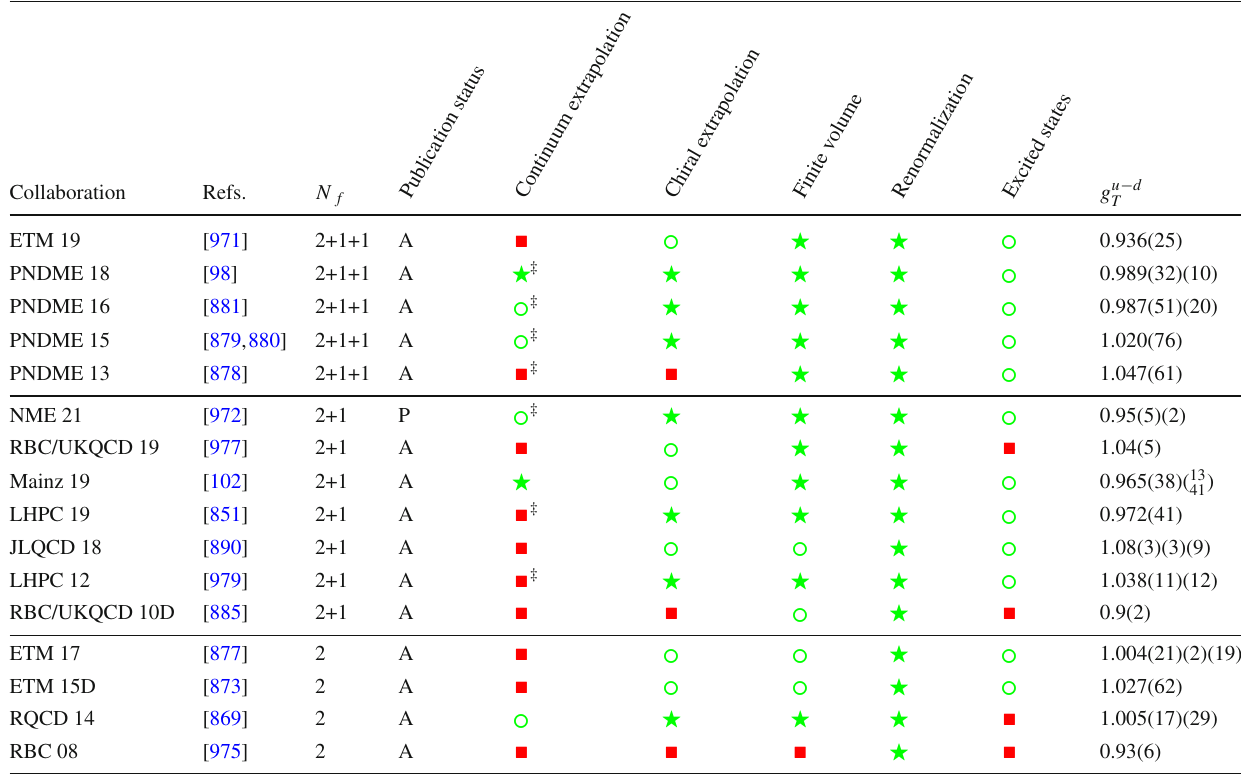
Table 71 Overview of results for g u − d